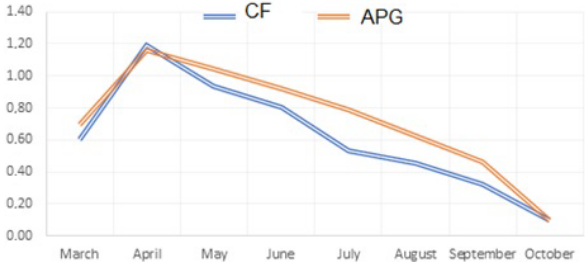
Figure 2. Lactation curves of the ewes’ different management sys-